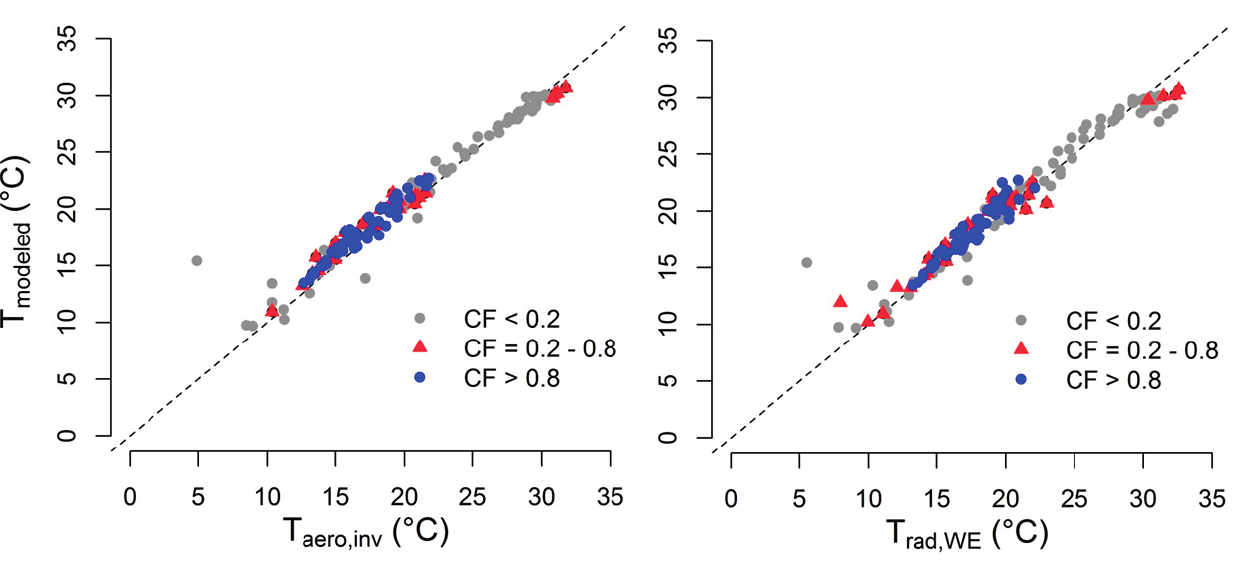
Figure 8. Scatter plot between the modeled daytime canopy temperature ( T cf. Section 3.3) and the inverted aerodynamic temperature ( T image-based temperature of wheat ears ( T